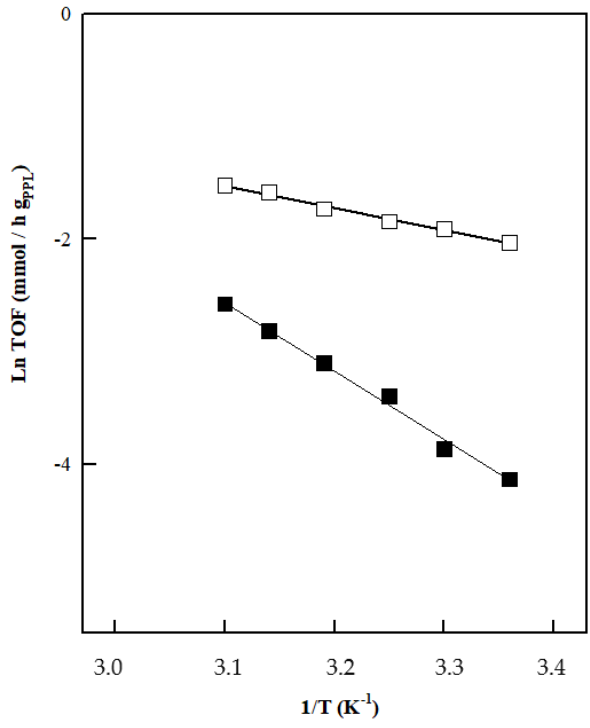
Figure 1. Arrhenius plot for the catalytic hydrogenation of acetophenone ( □ ) and propiophenone ( ■ ) over AlPO 4 -Sepiolite@ 1 , 0.032 mol of substrate, 90 atm of hydrogen pressure in methanol as solvent and different reaction temperatures. Table 6. Activation parameters E a (Kcal/mol) and lnA (h − 1 ), obtained from the Arrhenius plot of the catalytic hydrogenation of Acetophenone y Propiophenone over AlPO 4 -Sepiolite@ 1 , at the experimental conditions showed in Figure